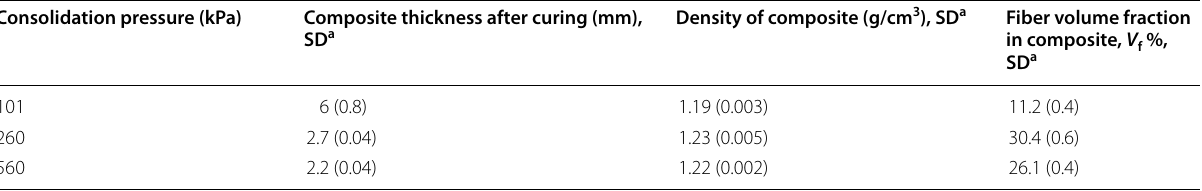
Table 3 Thickness, density, and fiber volume fraction of cattail composites manufactured at various consolidation